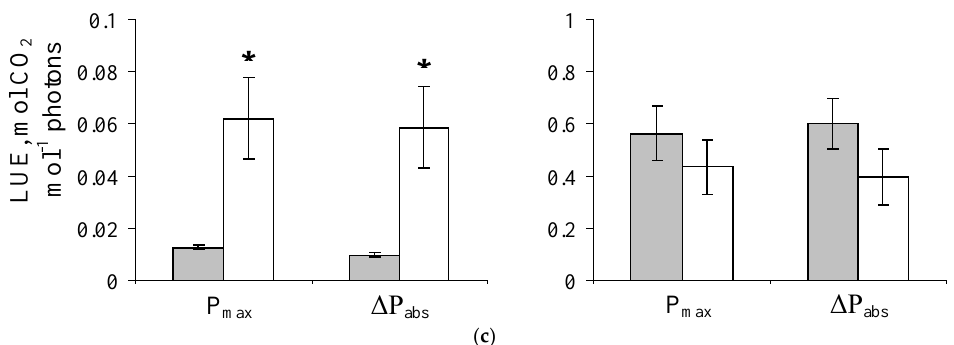
Figure 6. The influence of the distribution of ΔF/F m ’ ( a ); NPQ ( b ) and LUE ( c ) on investigated plants for the connection between these photosynthetic parameters with PRI with measurements under sunlight. Average values of P min (P max ) and ΔP abs are shown on left panels, average correlation coefficients are shown on right panels. The label “low” indicates groups with low P min (P max ) and ΔP abs ; the label “high” indicates groups with high P min (P max ) and ΔP abs . “Low” groups had n = 26 (ΔF/F m ’), n = 16 (NPQ), and n = 27 (LUE); “high” groups had n = 26 (ΔF/F m ’), n = 17 (NPQ), and n = 27 (LUE). * the group significantly differed from another one ( p < 0.05, Student’s test).